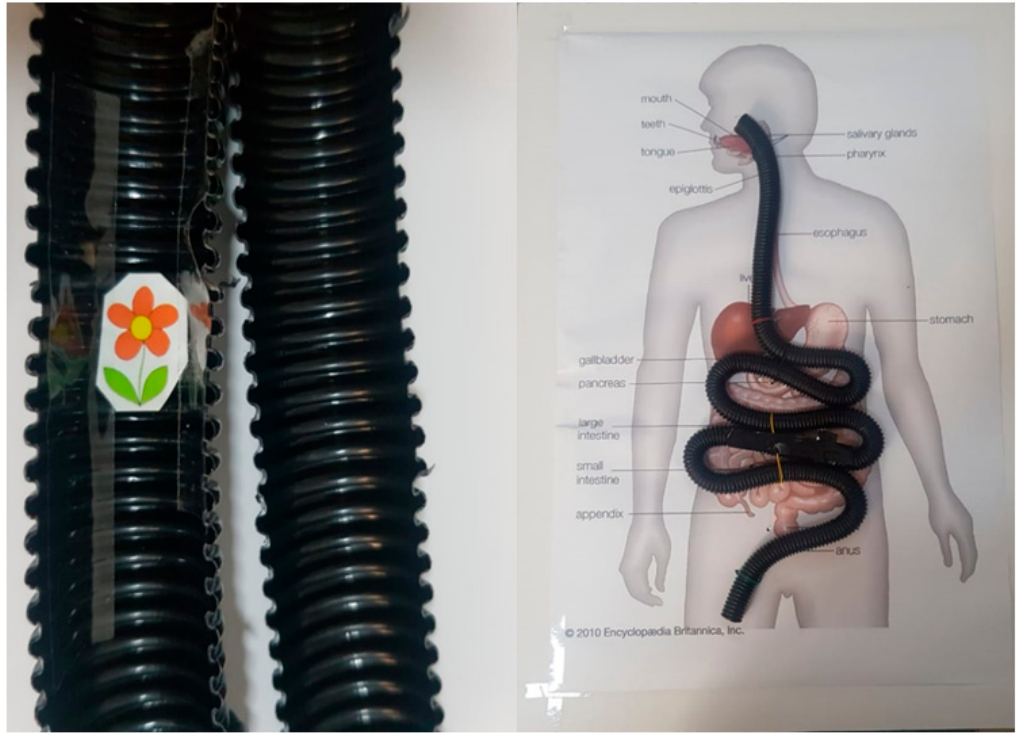
Figure 16. Tube with flower sample and the entire module test.